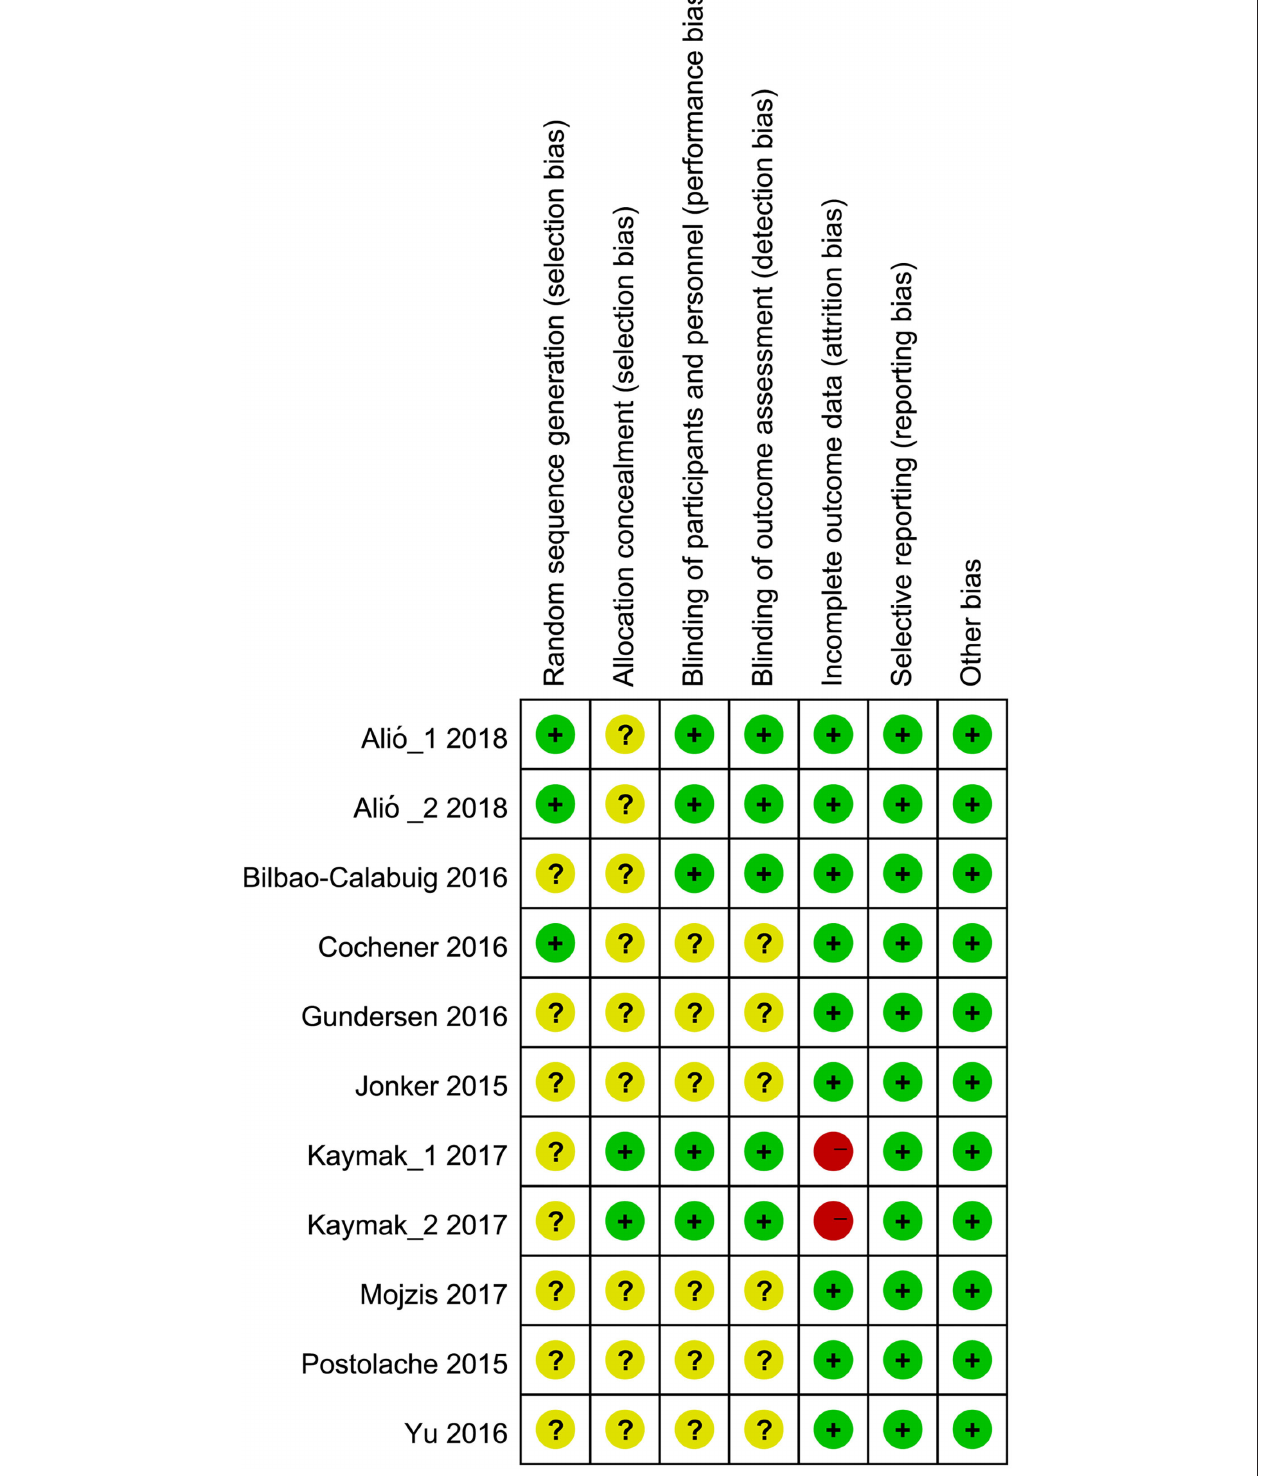
Frontiers in Medicine |